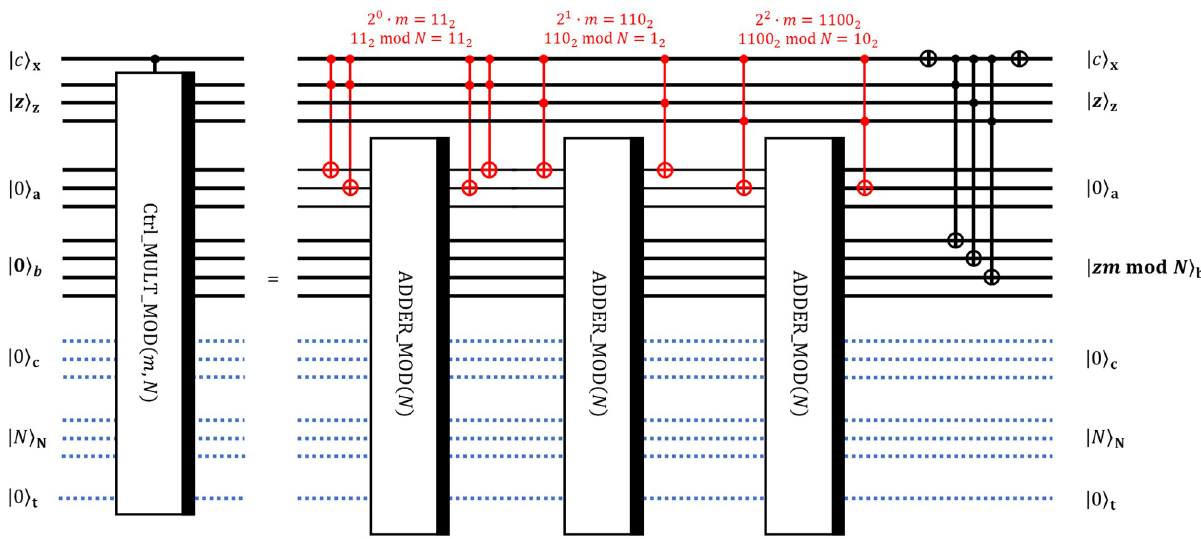
Fig 6. Decomposition of Ctrl_MULT_MOD circuit into lower-level operations. The decomposition realizes controlled modular multiplication of two 3-bit integers z and m modulo 3-bit integer N .